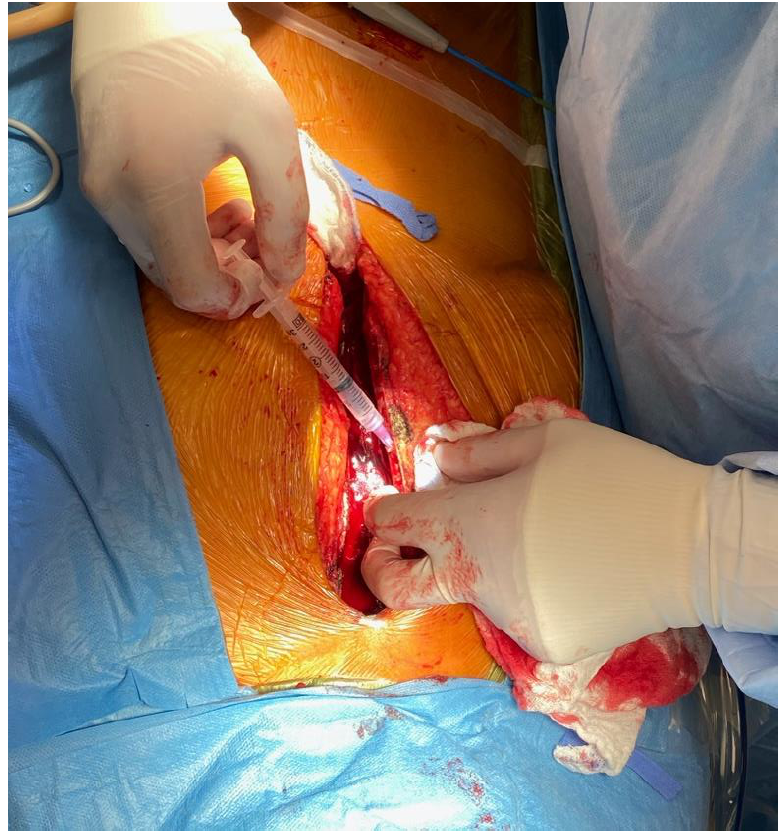
Figure 1. Sternal bone marrow harvest with a 5 mL blunt-tip syringe following a